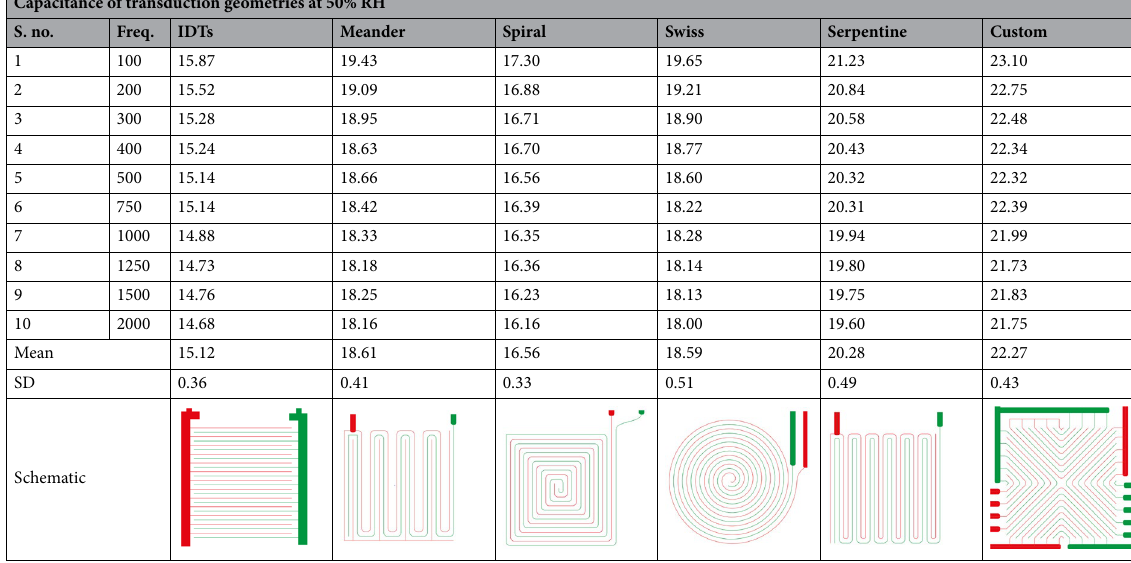
Table 2. Experimental resolution of screen templating through laser cutting